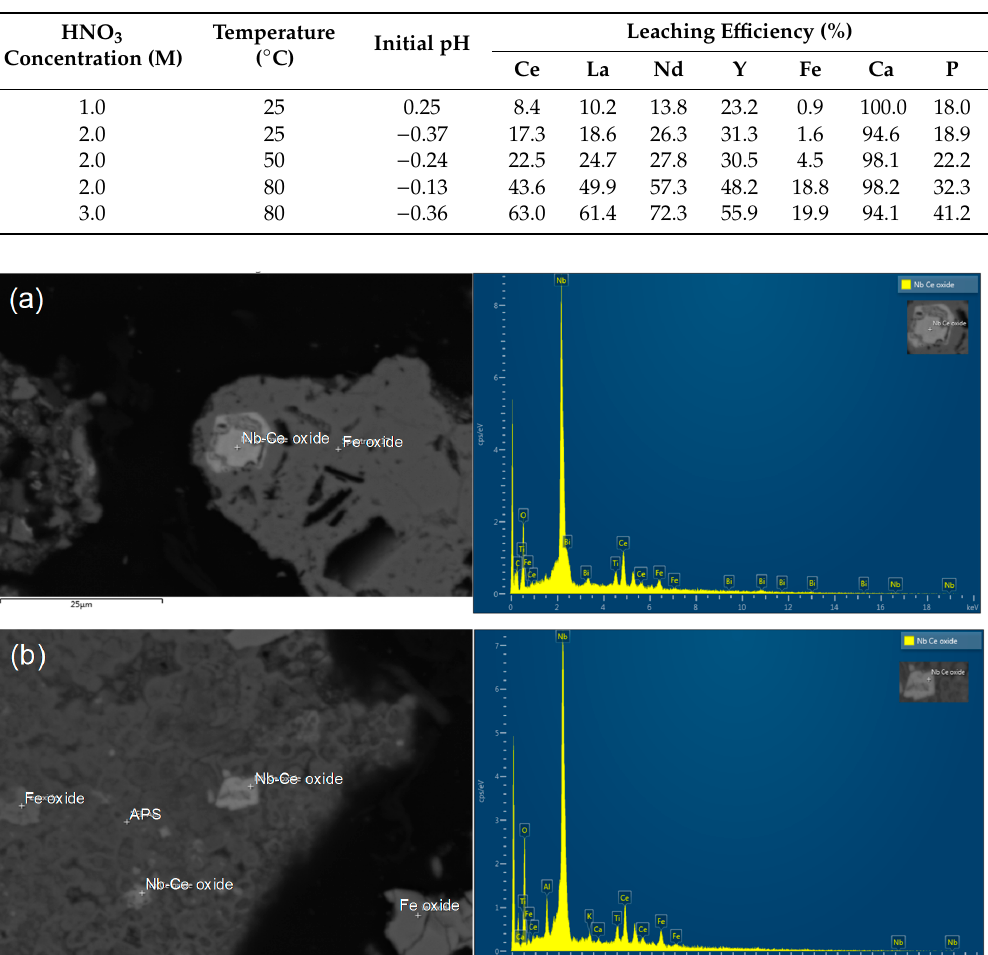
Figure 6. Preliminary leaching results: leaching efficiency (%) of REEs and impurities at different HNO 3 concentrations and temperatures.